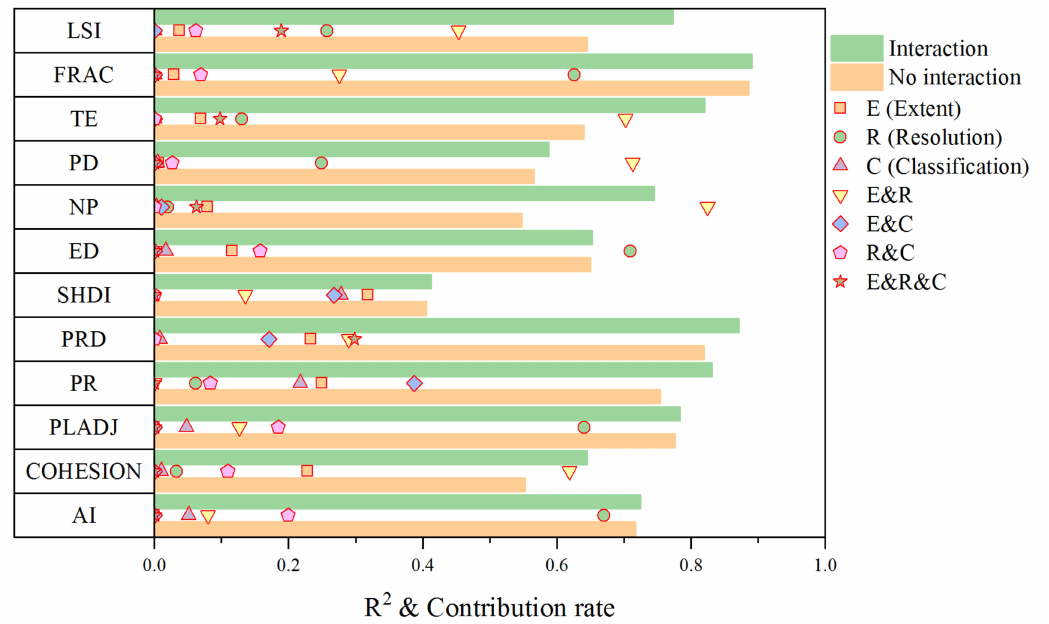
Figure 3. The comparison of interactions for 12 landscape metrics and the interactions’ contribution of the MARS model for multiple scale factors. E means the extent scale, R means the resolution scale, C means the classification